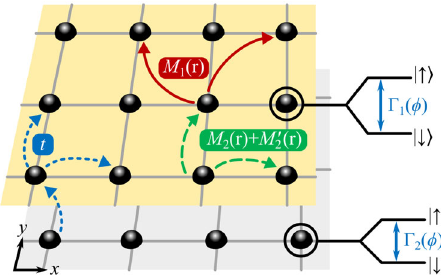
Fig. 4 Illustration of experimental setup. The atoms are con fi ned in a bilayer optical lattice. Couplings between opposite pseudo- spins are processed via laser fi elds of modes M 1 ( r ), M 2 ( r ), and M 0 The on-site energy offset is prepared as Γ λ ( ϕ ) which not only depends on the layer index but also is manually controlled by the parameter ϕ